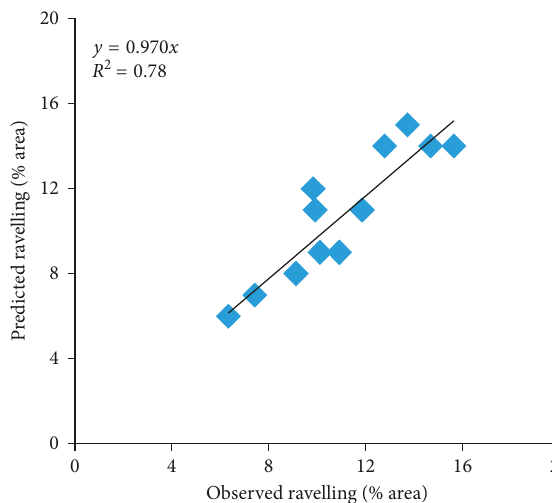
Figure 23: Scatter plot between observed versus predicted potholes for validation